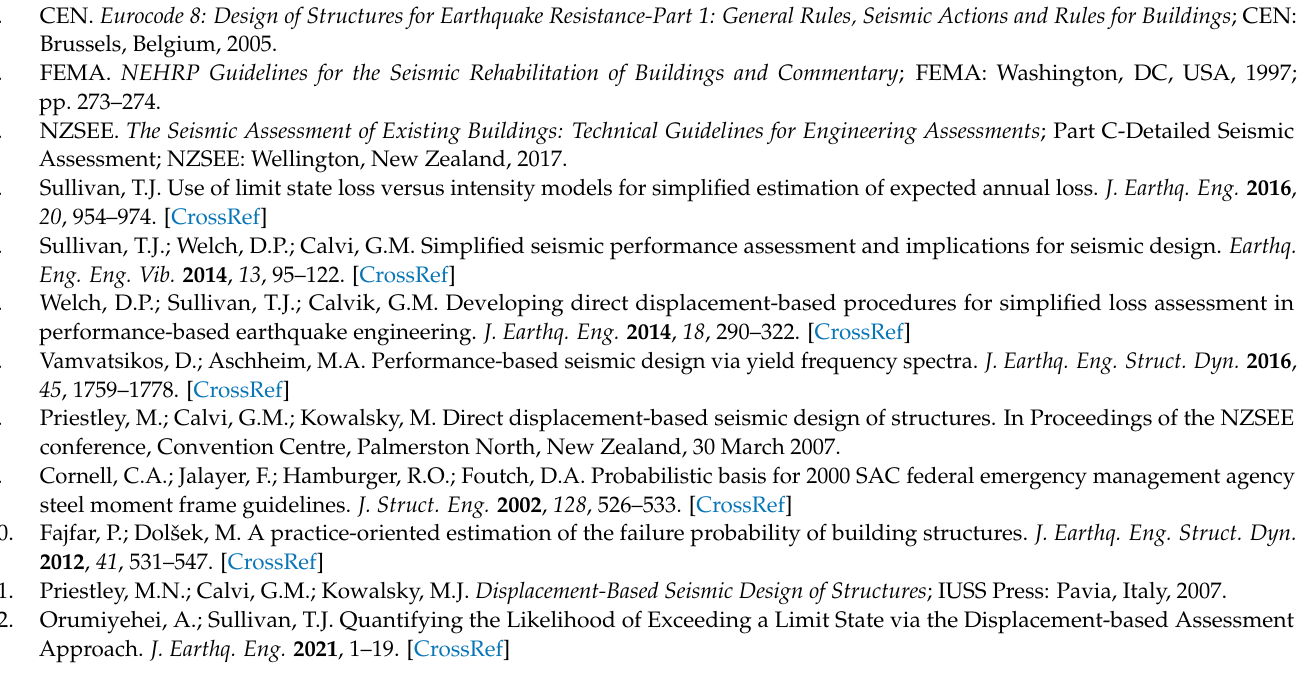
Following the above calculation, the annual probability of exceeding the curvature mechanism limit state is found to be 0.0036, which is also reported in Table 7.